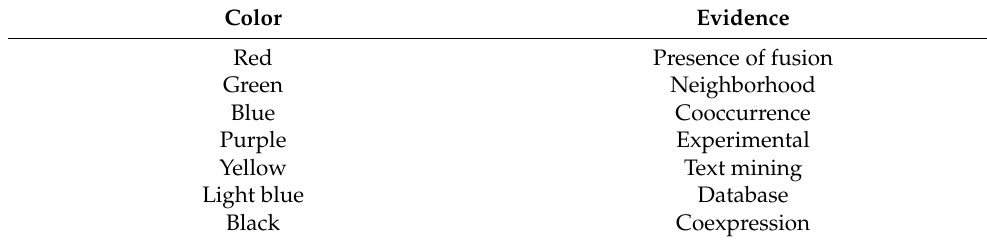
Note: Different color lines indicate types of interaction evidence used in predicting the association.